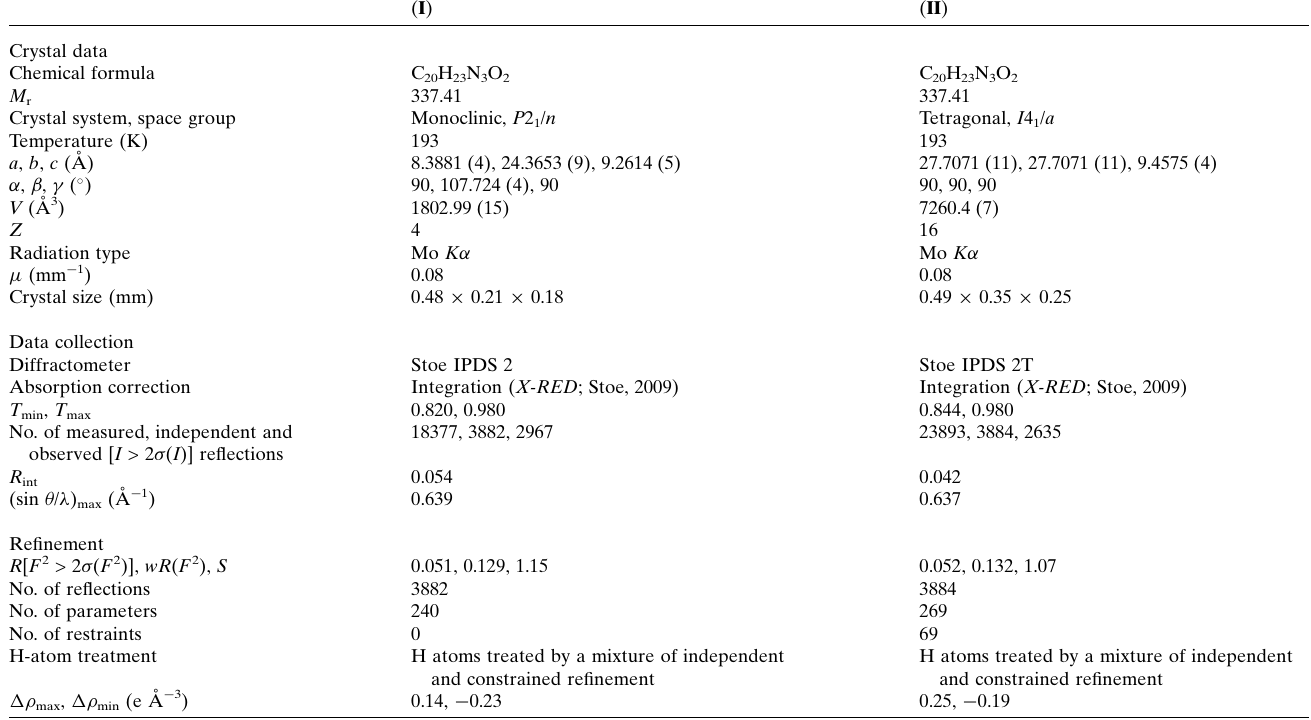
Table 6 Experimental details.